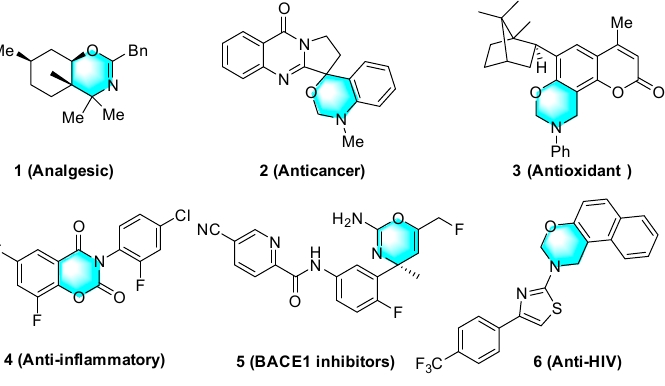
Figure 1. Examples of oxazine drug candidates.